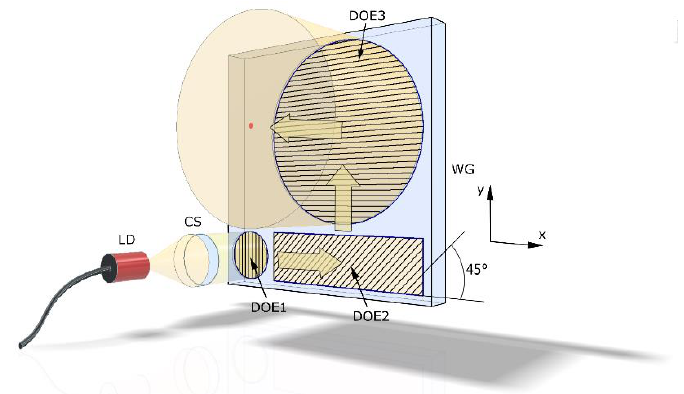
Figure 1. The scheme of radiation propagation in a holographic waveguide. DOE1 — input area, DOE2 — relay area, DOE3 — output area.